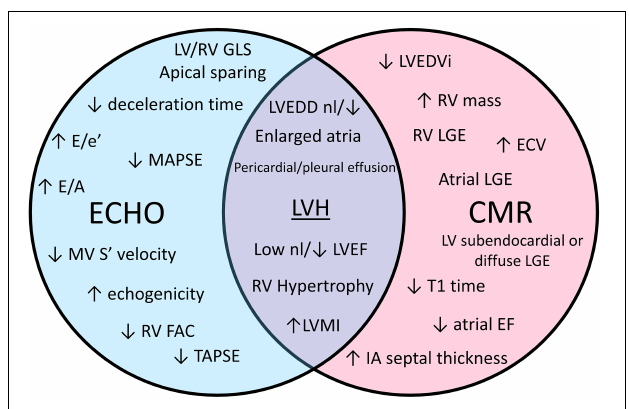
FIGURE 2 | A Venn diagram comparing echocardiogram (echo) and cardiac magnetic resonance (CMR) characteristics seen in cardiac amyloidosis. ECV, extra cellular volume; EF, ejection fraction; FAC, fractional area change; GLS, global longitudinal strain; LGE, late gadolinium enhancement; LV, left ventricle; LVEDD, left ventricular end diastolic diameter; LVEDVi, left ventricular end diastolic volume index; LVH, left ventricular hypertrophy; LVMI, left ventricle mass index; MAPSE, mitral annular plane systolic excursion; MV, mitral valve; nl, normal; RV, right ventricle; TAPSE, tricuspid annular plane systolic excursion.